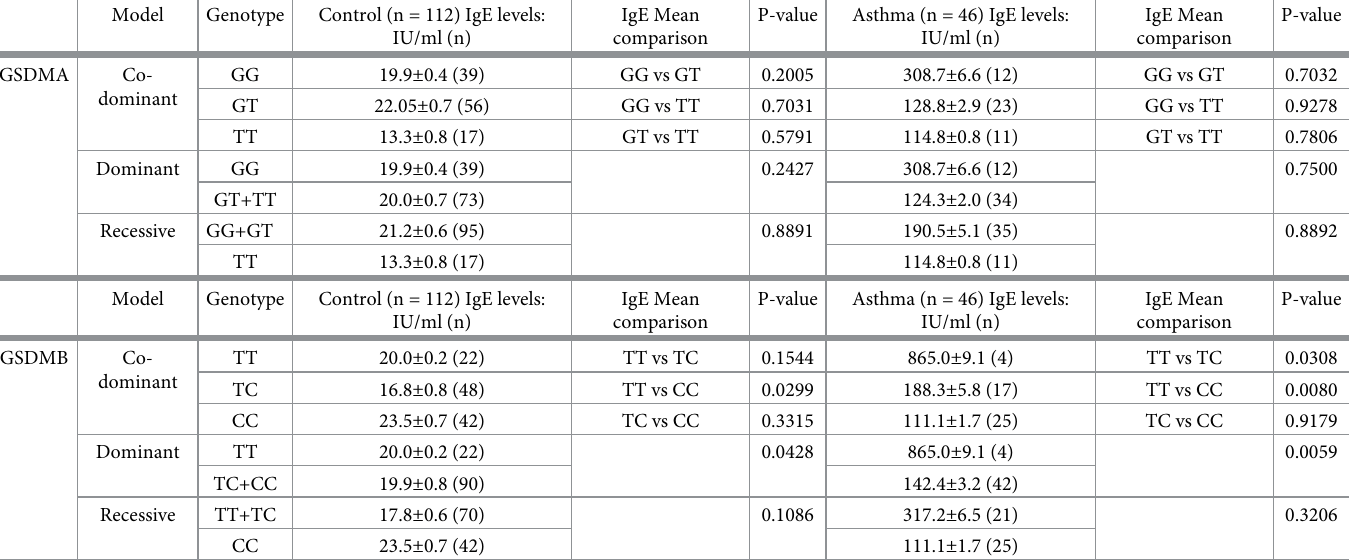
Table 2. Comparison between IgE levels of children asthma patients and control group according to GSDMA and GSDMB.